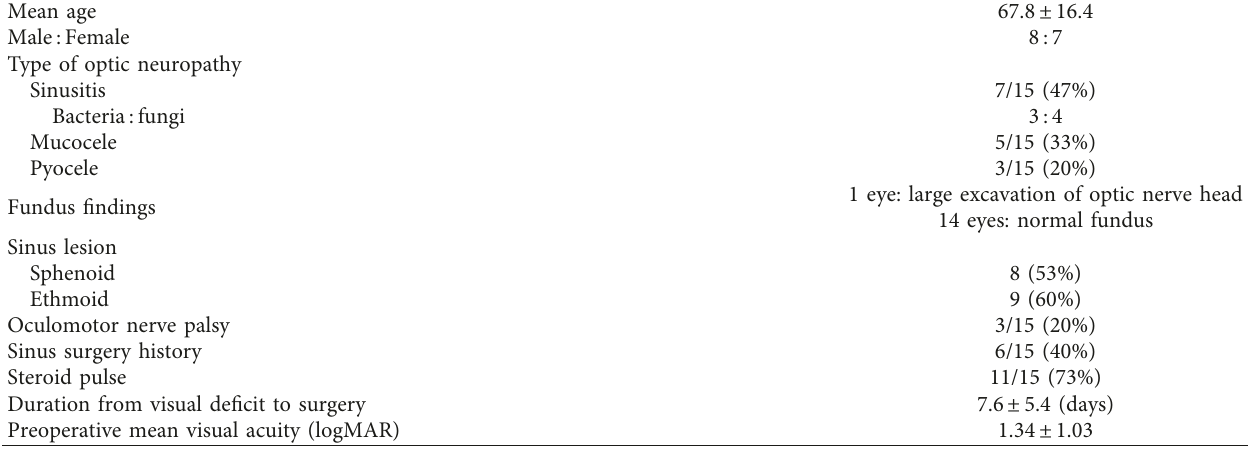
Table 1: Clinical characteristics of the 15 cases.